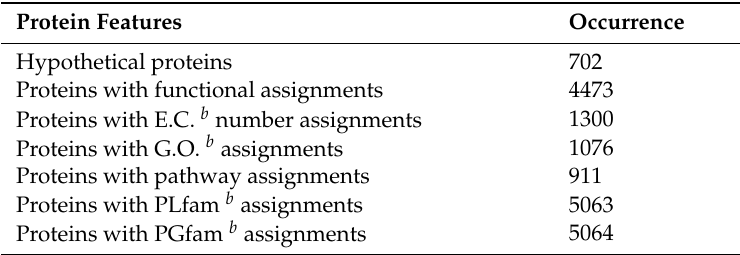
Table 1. EC121 annotation overview. a